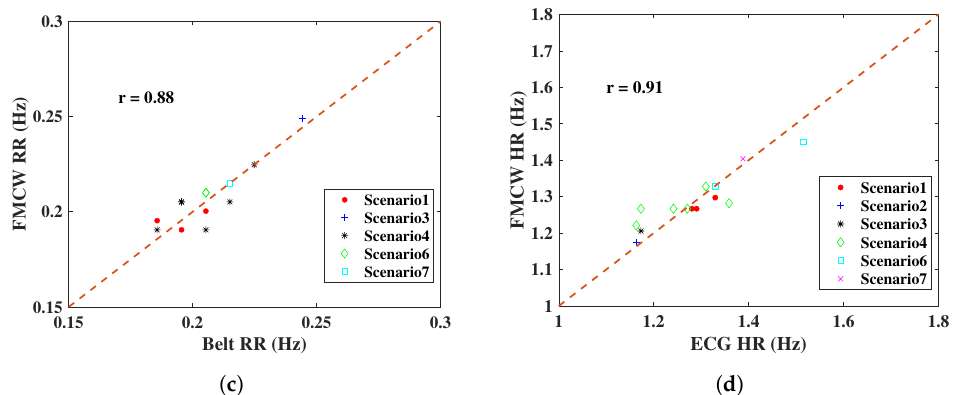
Figure 15. RR and HR results of radar comparisons with reference sensors in the designed scenarios; ( a ) RR comparison of IR-UWB radar, ( b ) HR comparison of IR-UWB radar, ( c ) RR comparison of FMCW radar, ( d ) HR comparison of FMCW radar. The correlation coefficient r is on the upper left.